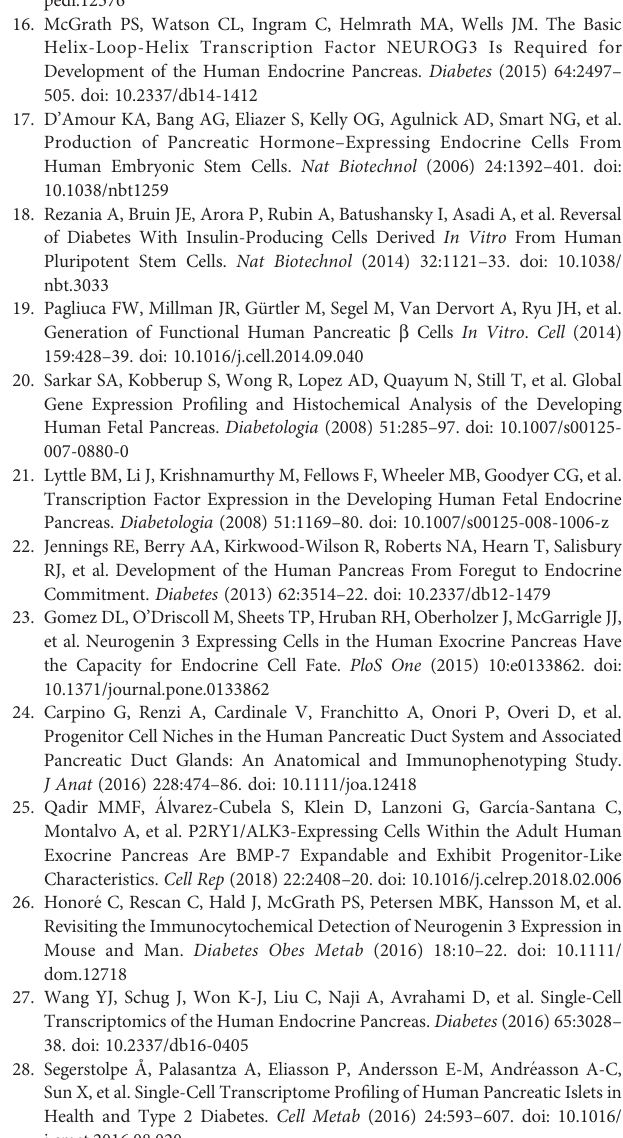
Supplementary Figure 2 | Genome browser view of the aligned reads in the 12 NEUROG3+ cells at the NEUROG3 genomic region. (A) In each of the 12 NEUROG3+ cells, there are fragments mapped to the exons of NEUROG3 . (B) The boxed region in A is zoomed to single nucleotide resolution. Red dash line indicates the starting siteof an adjacenttranscript. Thealigned fragmentsallhave nucleotides mapped beyond the starting site of the adjacent transcript, con fi rming that these reads originate from NERUGO3 mRNA. Supplementary Figure 3 | Islet regulome snapshots show transcription factor binding sites in the promoter/enhancer regions of 5 novel regulators including (A) MEIS2, (B) NFIA, (C) PBX3, (D) PROX1, and (E) SMAD5. Supplementary Figure 4 | NEUROG3+ cells in the postnatal human pancreas do not cluster together with NEUROG3+ cells derived in vitro . (A) UMAP displays the effect of data alignment. Cells are colored according to their study sources. Krentz dataset contains NEUROG3+ cells derived from stage 6 day 1 of in vitro